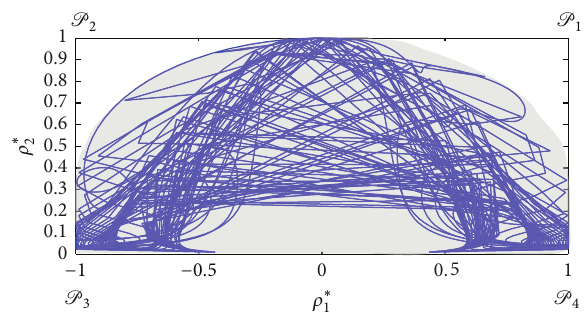
Figure 4: Operating region of the scheduling parameters 𝜌 ∗ 1 and 𝜌 ∗ 2 .